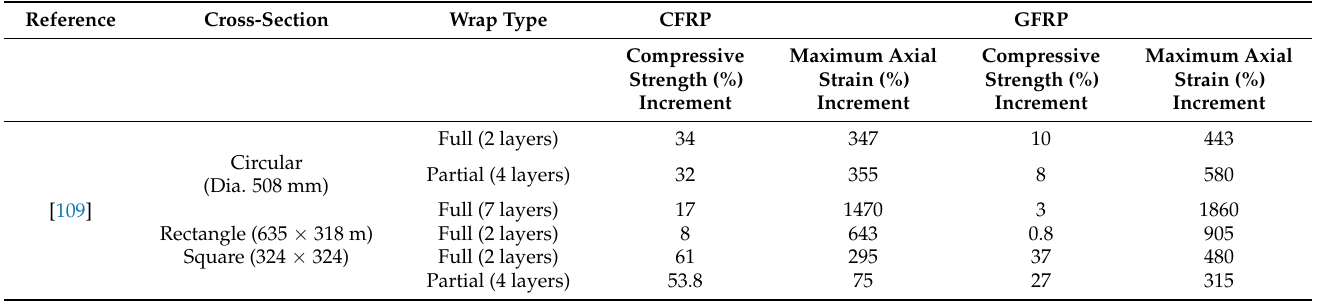
Table 6. Compressive strength increment and wrapped specimen maximum axial strain, compared to unwrapped ones.